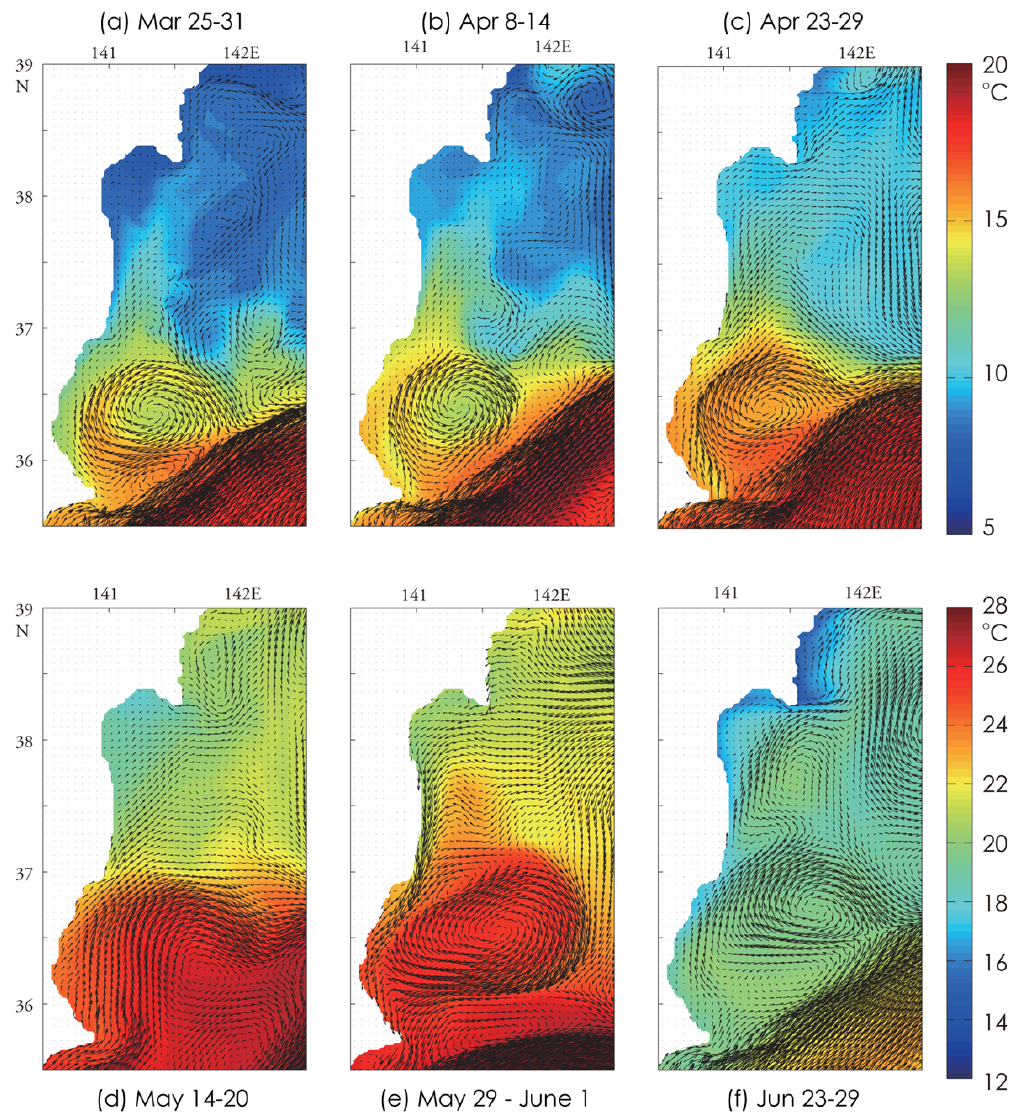
Fig. 4. Simulated surface flow fields and the SST for CTRL. (a) 25–31 March, (b) 8–14 April, (c) 23–29 April, (d) 14–20 May, (e) 29 May– 1 June, and (f) 23–29 June 2011. Color contours are shown on the top right for (a–e) but bottom right for (f) . The color contour is different for (f) so that it is similar to Fig.